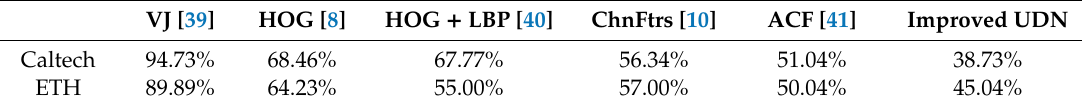
Table 1. Log-average Miss Rate (LAMR) of improved UDN and hand-crafted feature-based models. VJ [39] HOG [8] HOG + LBP [40] ChnFtrs [10] ACF [41] Improved UDN Caltech